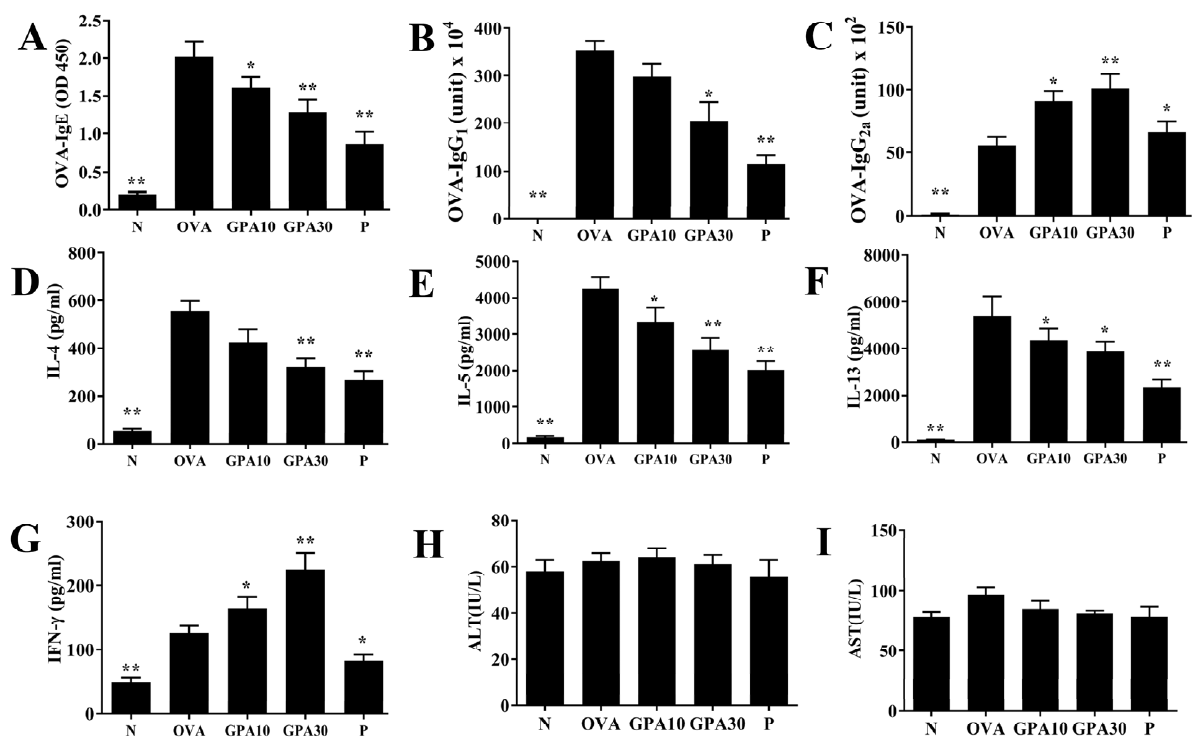
Figure 4. Effects of gypenoside A (GPA) on the levels of cytokines and antibodies in serum and splenocytes. Serum levels of ( A ) OVA-IgE, ( B ) OVA-IgG1, and ( C ) OVA-IgG2a in mice. Gypenoside A modulated the levels of ( D ) IL-4, ( E ) IL-5, ( F ) IL-13, and ( G ) IFN- γ produced by OVA-activated splenocytes. Effects of gypenoside A on serum biochemical value, including ( H ) ALT and ( I ) AST. The data are presented as the mean ± SEM of three independent experiments (n = 8 per group). * p < 0.05, ** p < 0.01 compared with the OVA control group. Normal saline control group were named as N; Ovalbumin (OVA)-induced asthma mice were named as OVA. The 10 mg/kg and 30 mg/kg gypenoside A were named as GPA10 and GPA30, respectively. The 5 mg/kg prednisolone was named as P.